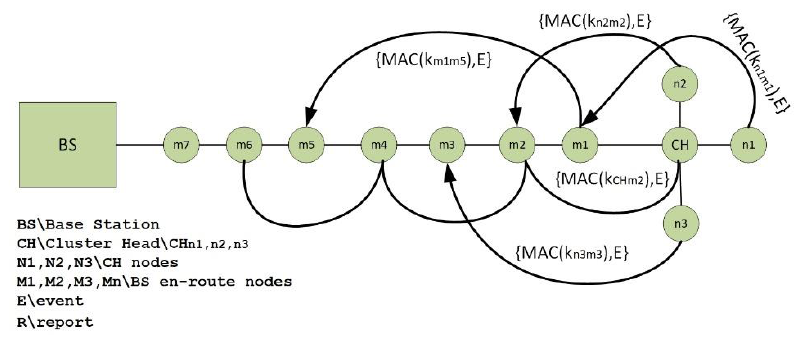
Figure 3. IHOP Mechanism. Figure 3. IHOP